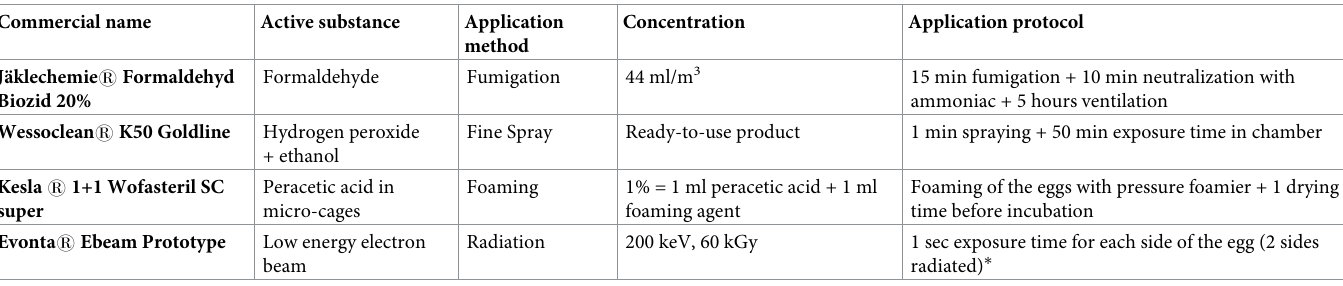
Table 1. Disinfection methods and protocols used during trials. Application protocols were performed according to the information provided by the producer. Commercial